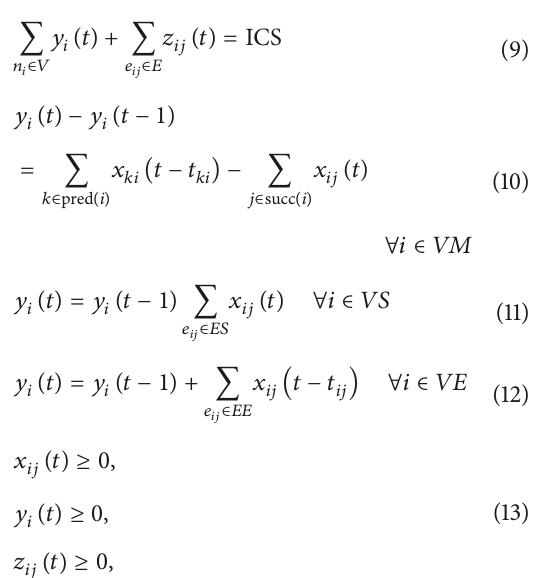
Algorithm 3: The simulating calculation